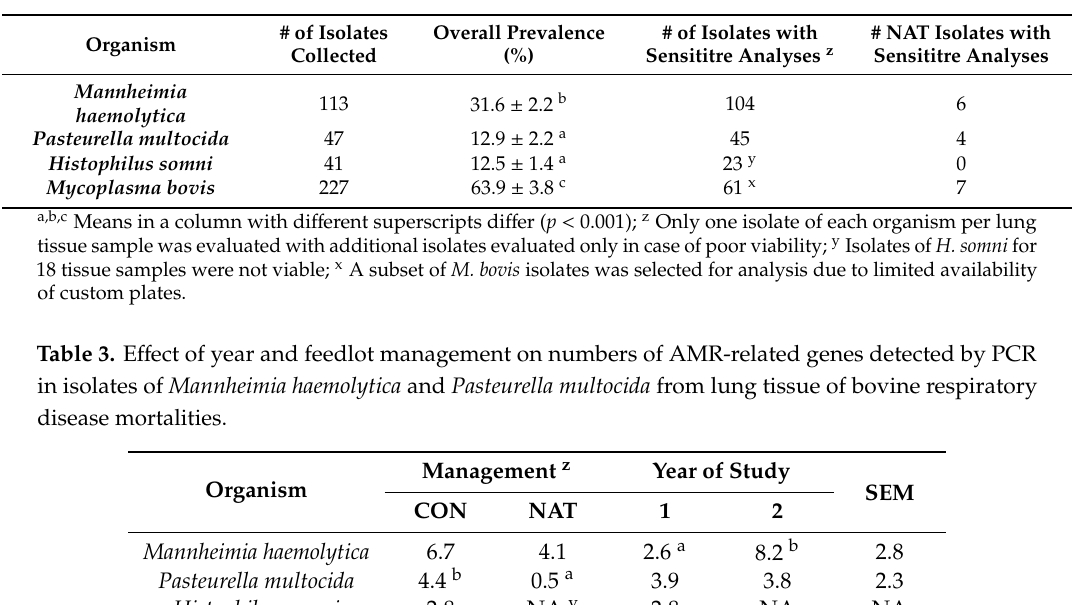
Table 2. Overall prevalence of isolates recovered from lung tissue of bovine respiratory disease mortalities ( n = 350).